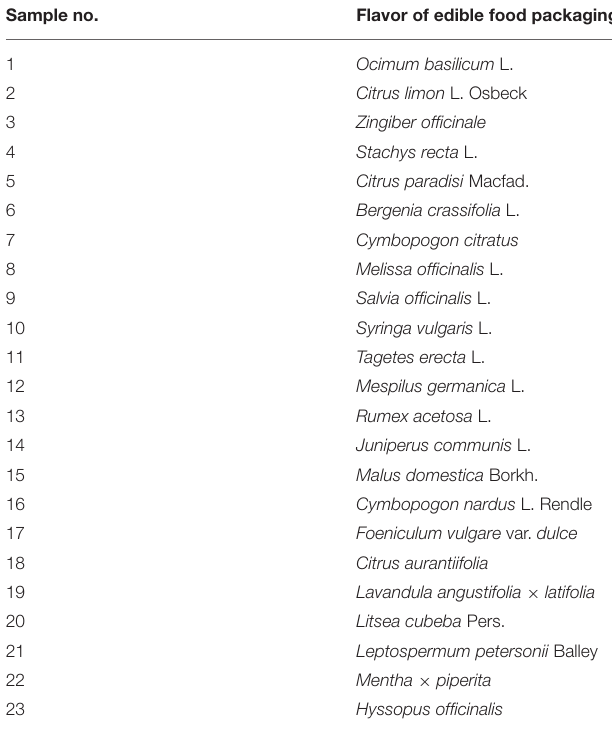
TABLE 1 | Different flavors of edible food packaging. Sample